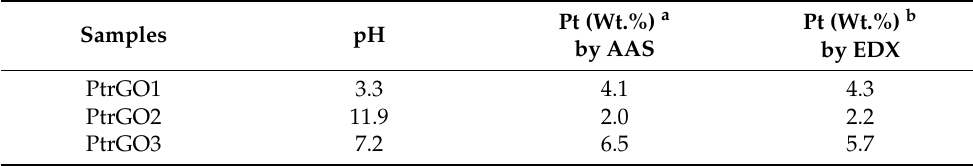
Table 1. The average concentration of Pt by atomic adsorption and EDX [34]. Samples